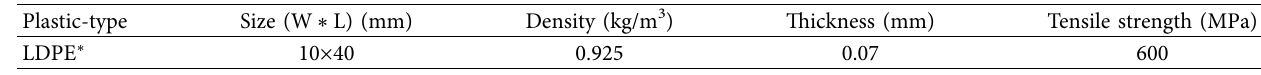
Figure 2: Waste metalized plastics in (a) original form and (b) fiber form. Table 4: Properties of MPW fibers.